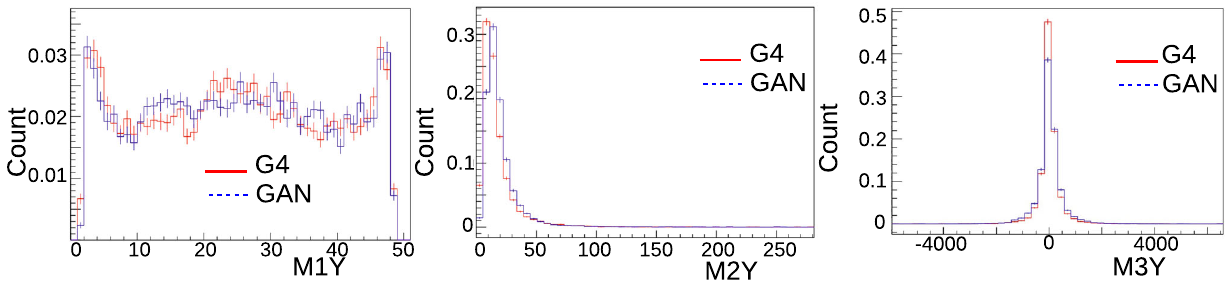
Fig. 16 Shower moments along Y axis for GEANT4 vs. GAN charged pions. (Left) M 1 Y (shower center). (Mid) M 2 Y (shower width). (Right) M 3 Y (shower